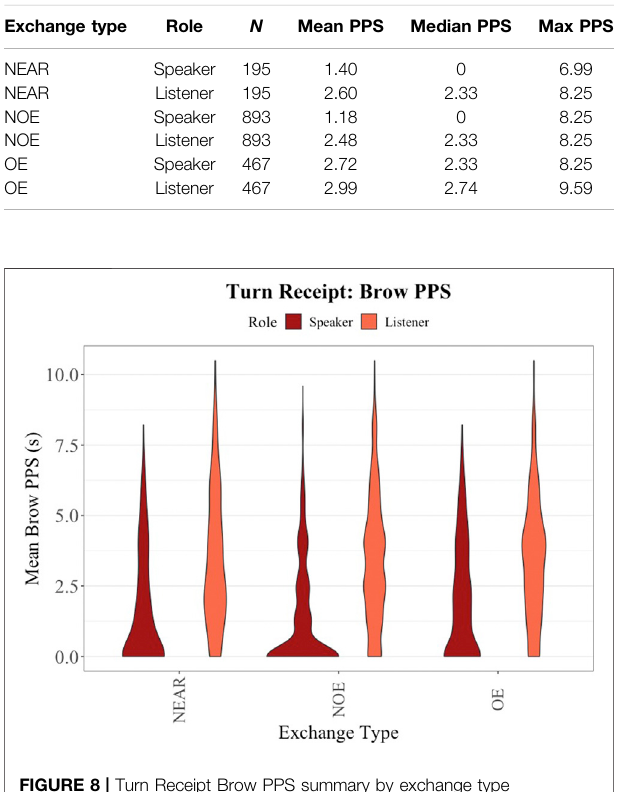
Supplementary Table S7 . In a contrast-coded model testing the